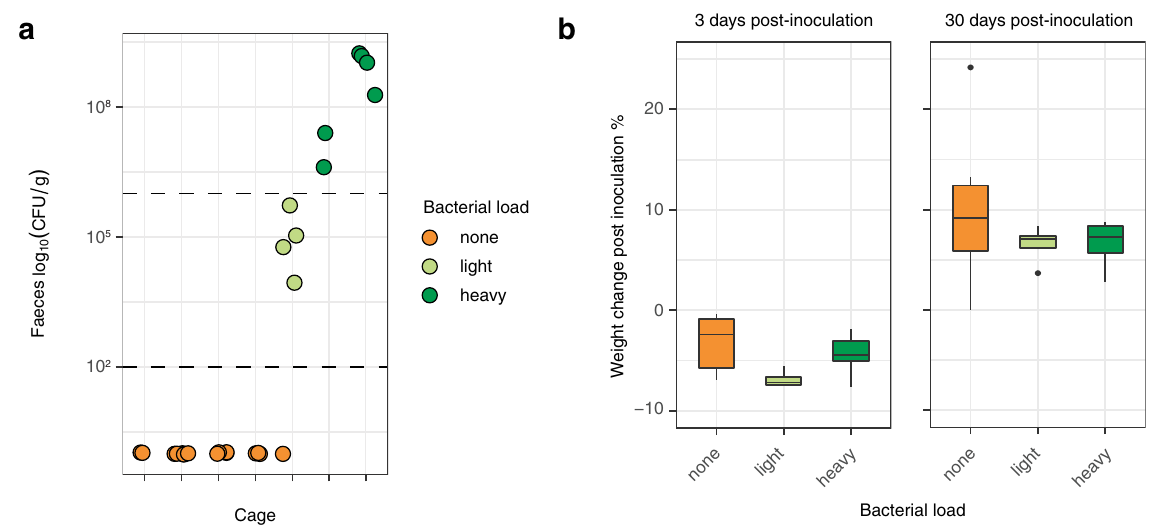
Fig. 5 Lm faecal carriage in mice is cage-dependent. a CFU/g of the stool of male mice 30 days after an iv challenge with Lm at 5 × 10 3 CFU from different cages (2 – 6 mice per cage). Colour indicates carriage group (<100 CFU/g: none, 100 – 10 6 CFU/g: light, >10 6 CFU/g: heavy). Horizontal lines indicate the threshold between the groups. b Body weight change of mice after inoculation at 3 days post-inoculation and 30 days post-inoculation according to their carriage group ( n none = 16, n low = 4, n high = 6; 3 dpi: none vs. heavy P = 0.37, low vs. heavy P = 0.11; 30 dpi: none vs. heavy P = 0.37, low vs. heavy P = 0.91). The statistical comparison was performed with a two-sided Wilcoxon rank-sum test. For boxplots, the hinges represent the fi rst and third quartile of the distribution. The whiskers extend from the hinge to the largest or smallest value no further than 1.5 x IQR from the respective hinge (where IQR is the inter-quartile range or distance between the fi rst and third quartiles). Points beyond this limit are datasets were re-aligned using mafft v. 7.407 65 , and trimmed using trimal v.1.4 66 using the ‘ automated1 ’ algorithm. The resulting trimmed sequences were then clustered within each sample at 99% identity and 90% coverage using the uclust algorithm from usearch v. 10.0.240 67 . Non-redundant reads which were present >3 were considered in the analysis. A representative sequence of each cluster was de fi ned according to the distance to the cluster centroid. Henceforth, we will call these our environmental dataset. To identify Listeria ssp. in the environmental dataset we used a maximum obtained from Genbank 68 and aligned using mafft with the ‘ linsi ’ algorithm. The resulting multiple sequence alignment was trimmed using trimal v.1.4. Phylogenetic reconstruction was then performed using IQ-tree v.1.6.5 69 using the GTR model (according to the model test) and 1000 rapid bootstrap iterations. The resulting tree was manually pruned to leave only one representative member of each clade. Environmental sequences were then classi fi ed as potential Listeria candidates by mapping them against the multiple sequence alignment using the ‘ -addfragments ’ algorithm of mafft. Sequences with at least 90% identity and 90% coverage to one reference member were kept for further analyses, or otherwise were discarded. The remaining sequences were then assigned to one of the branches of the phylogenetic tree using the evolutionary placement algorithm implemented in RAxML v. 8.2 70 . Environmental sequences assigned to any terminal branches with a maximum likelihood of 0.6 or higher, were classi fi ed as the speci fi c Listeria species. Otherwise, they were classi fi ed as ‘ Listeria unde fi ned ’ . Note that this was